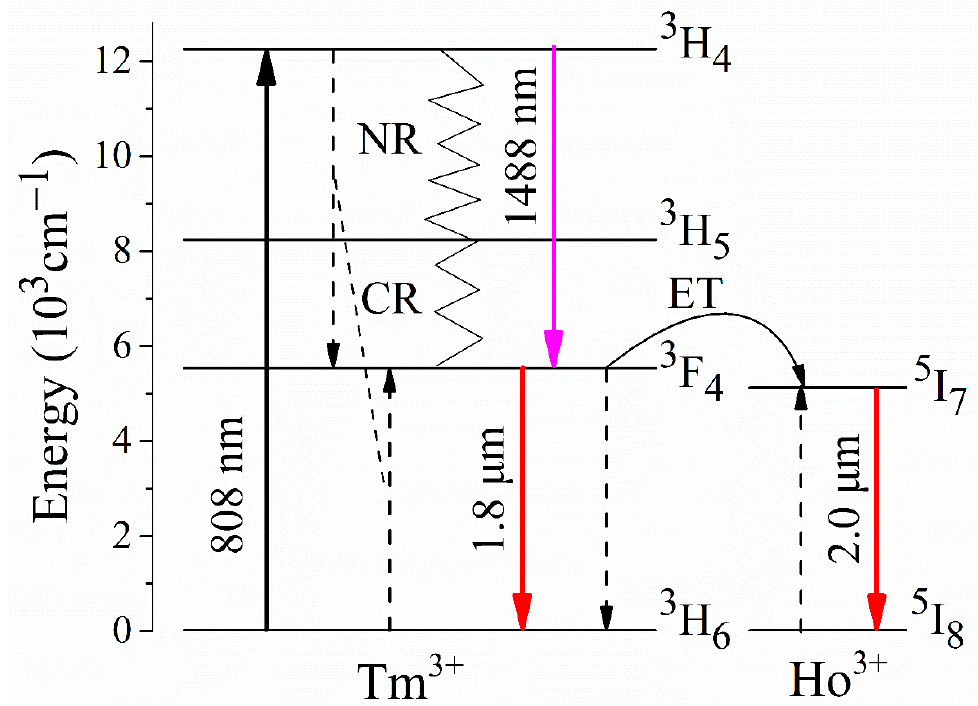
Figure 6. Simplified energy level diagram and energy transfer mechanisms for Tm 3+ /Ho 3+ co-doped system.